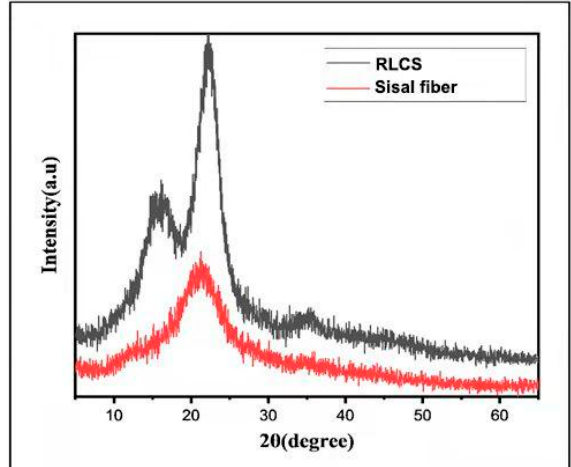
Figure 5. XRD analysis of raw sisal fibers and RLCs.